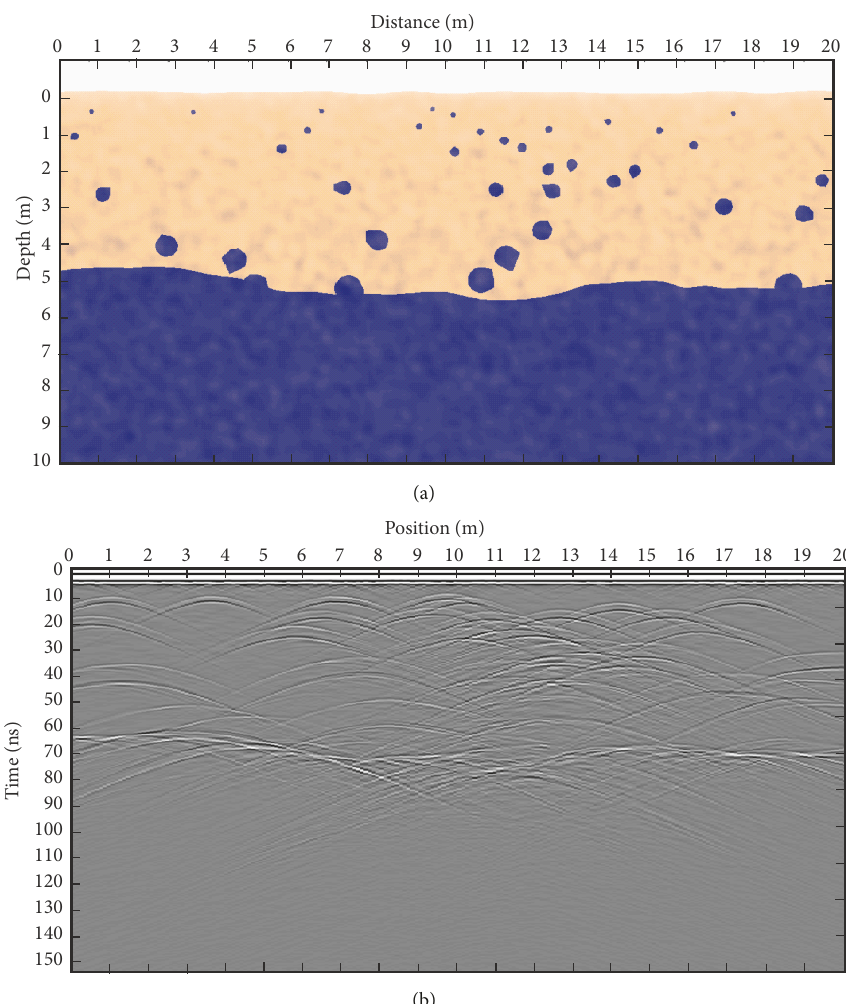
Figure 6: The integrated regolith model and its forward simulation